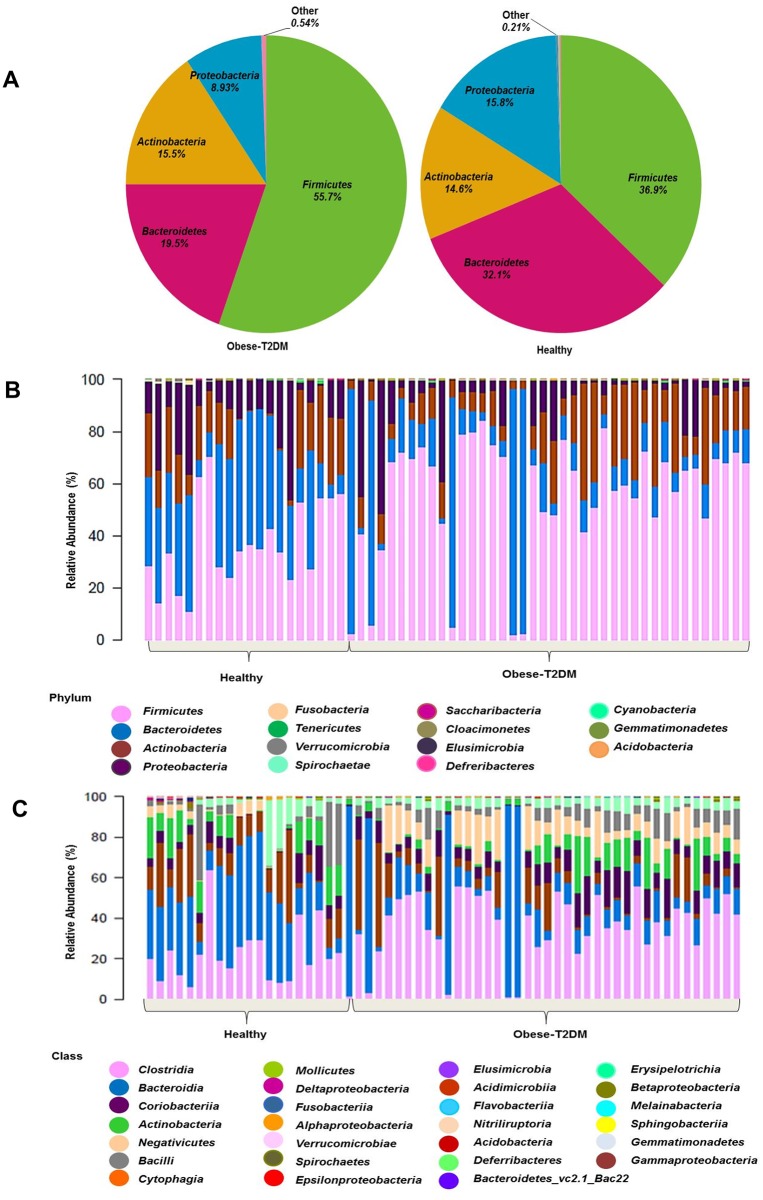
The relative abundance of gut bacteria in obese-T2DM patients and healthy participants using Kruskal-Wallis rank-sum tests.(A) Relative percentage of most abundant phyla between obese-T2DM patients (n = 40) and healthy individuals (n = 20). (B) Relative percentage of most abundant phyla in each sample between obese-T2DM patients (n = 40) and healthy individuals. (C) Relative abundance of bacteria at class level in obese-T2DM patients (n = 40) and healthy participants (n = 20).